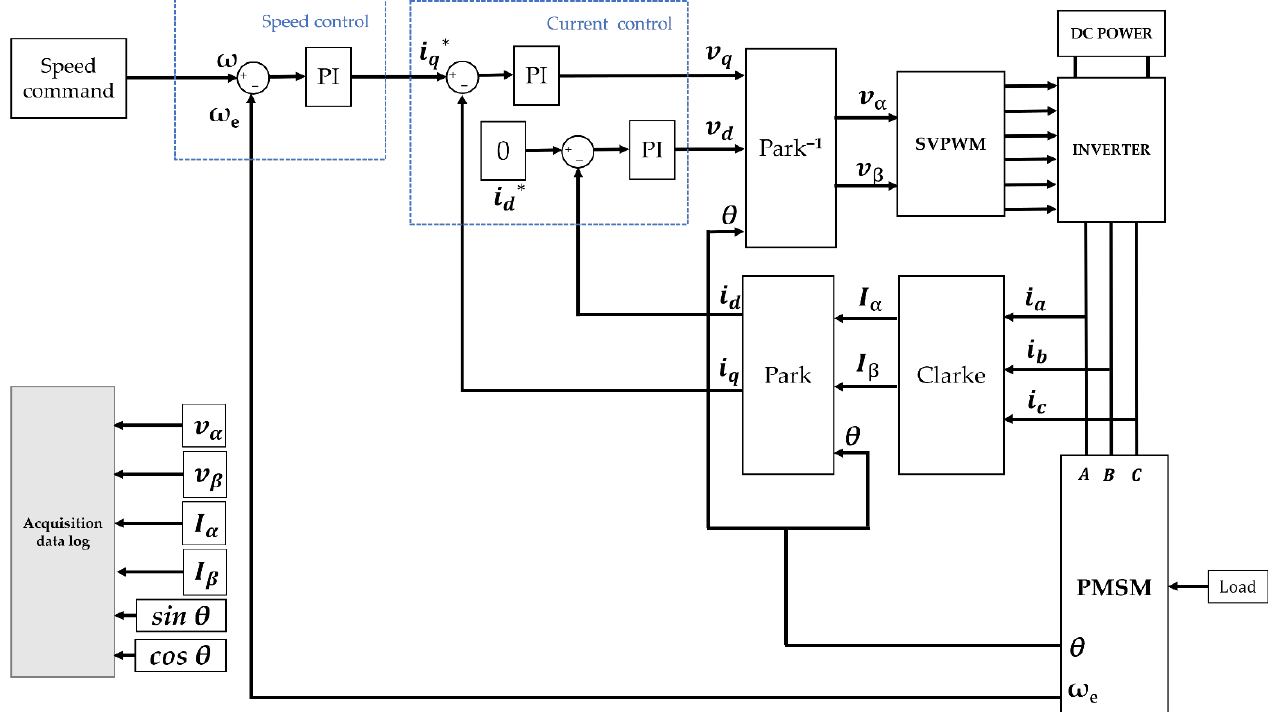
Figure 5. Sensored PMSM-FOC architecture for data acquisition.